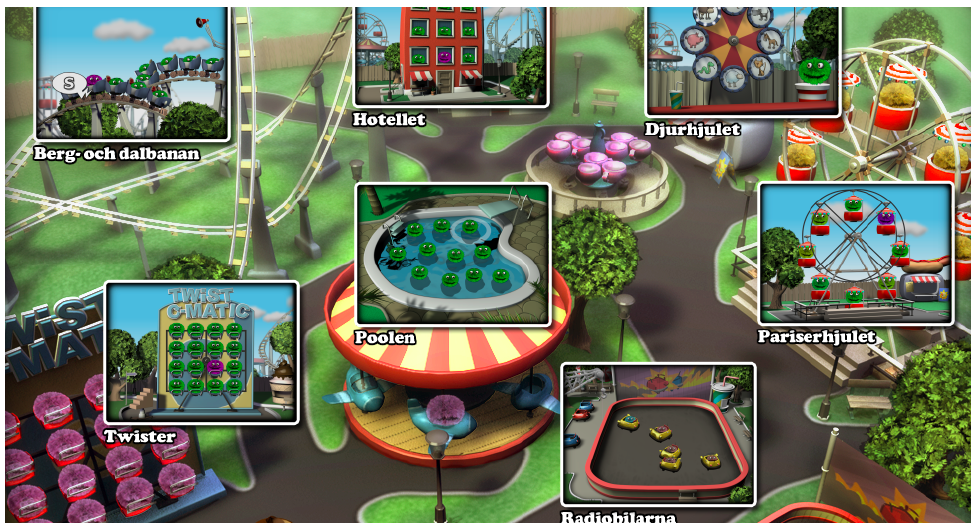
Figure 3. Screenshot of Cogmed Memory Training